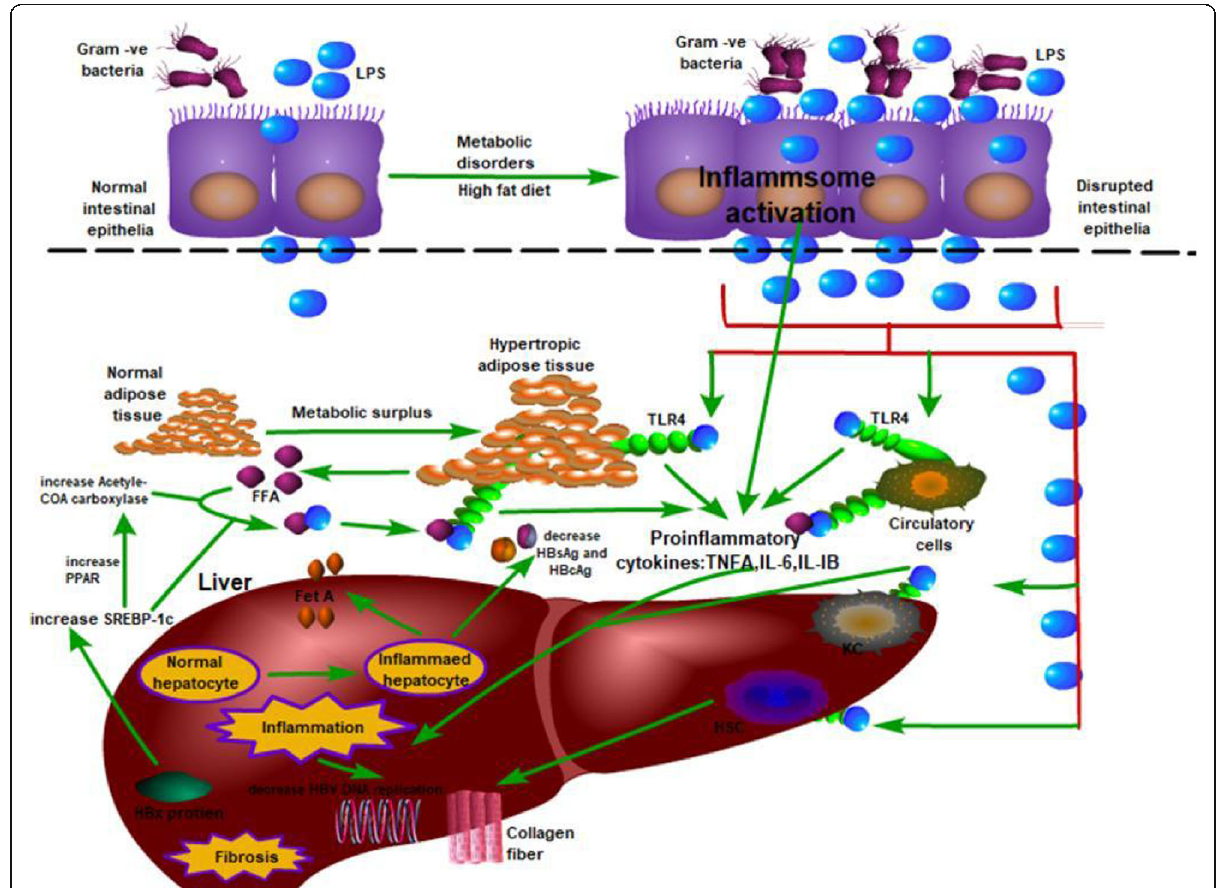
Fig. 2 The interplay between HBV, NAFLD, and innate